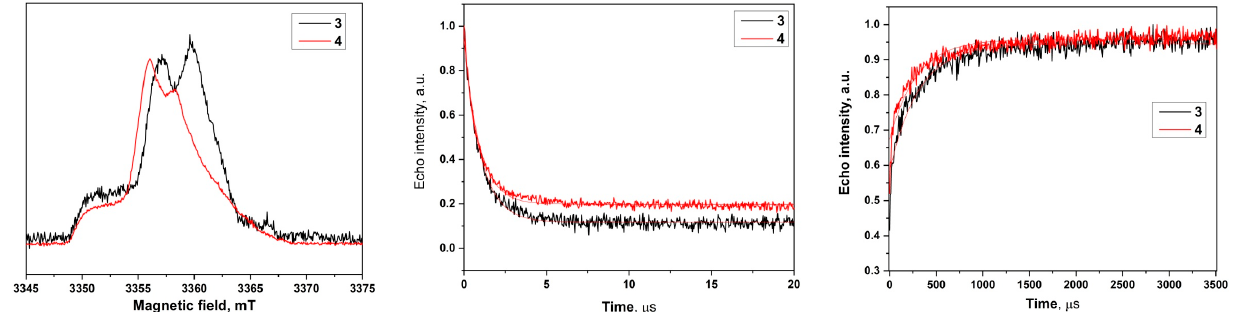
Figure 2. Left : The 94 GHz echo-detected EPR spectra (black: for 3 , red: for 4 ) at 80 K. Center : Intensity of spin echo of biradicals 3–4 at 80 K as a function of the time. Right : Inversion - recovery time traces of biradicals 3–4 at 80 K along with mono-exponential fits.